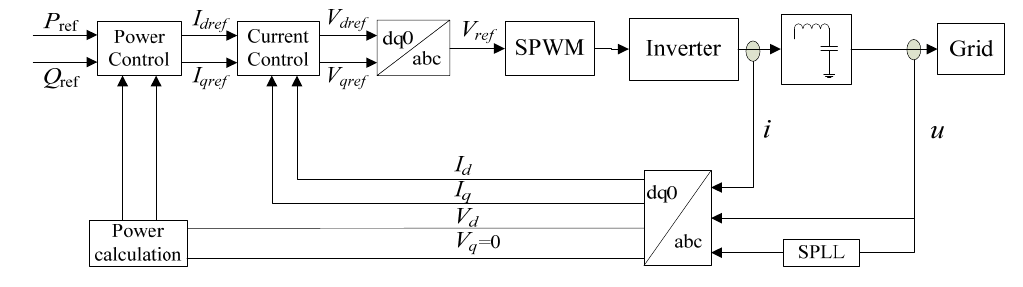
Figure 4. The schematic diagram of PQ control.